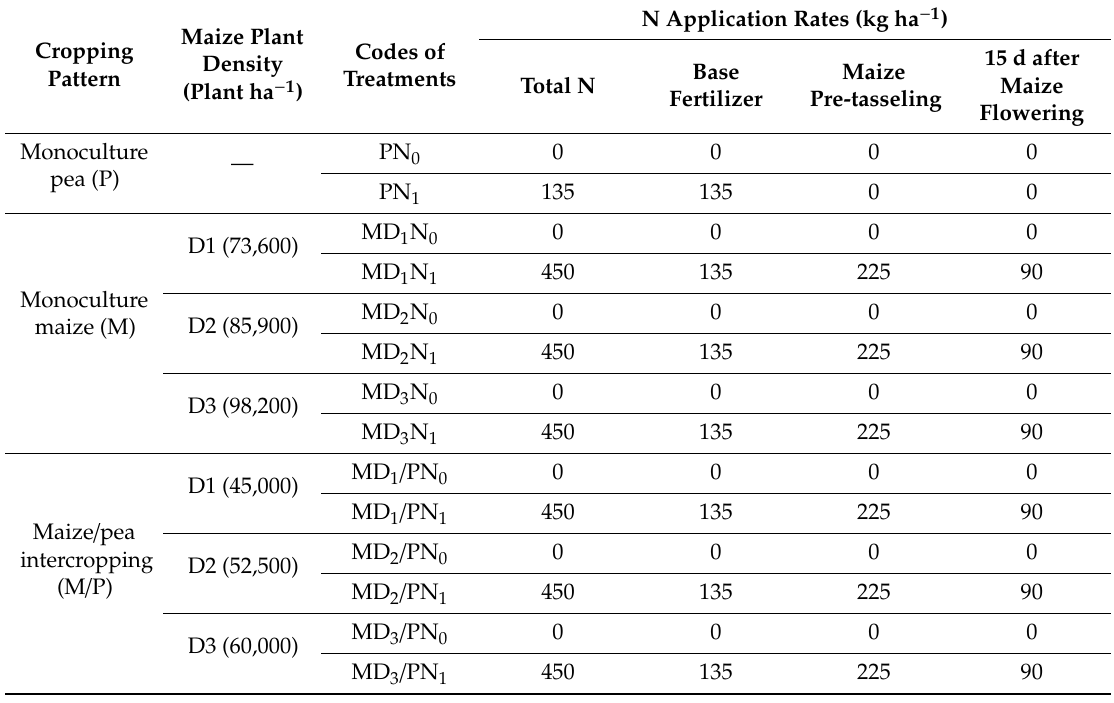
Table 1. Description of experimental treatments, including the maize density and nitrogen (N) fertilizer applied to pea at the co-growth stage.